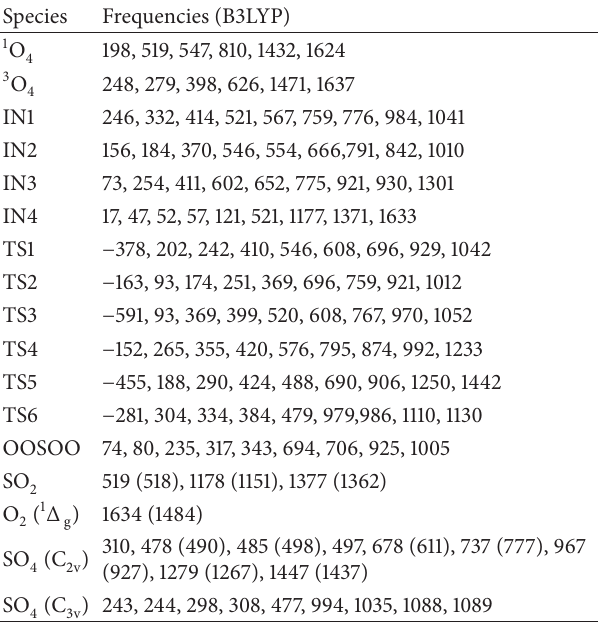
Table 3: The vibrational frequencies (cm − 1 ) of the reactants, prod- ucts, and transition states calculated at the B3LYP level. The value in parentheses refers to experimental data